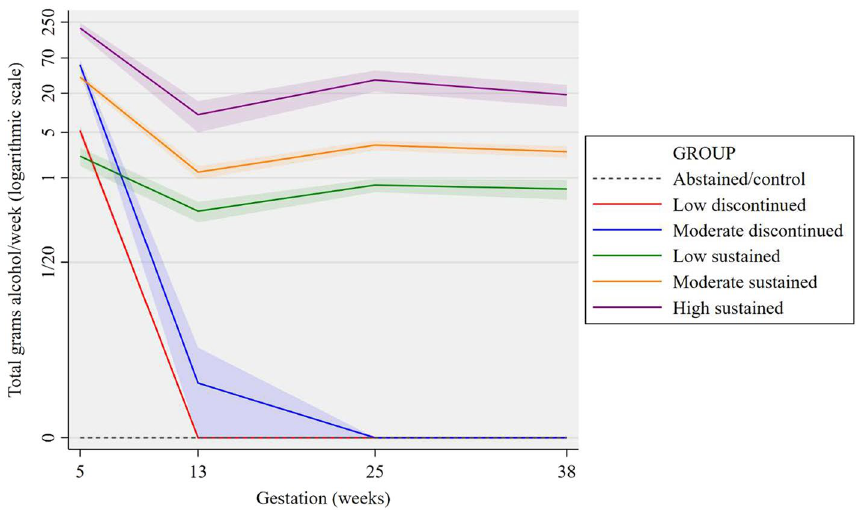
Figure 1. Trajectory groups for prenatal alcohol consumption based on the five-group model with abstainer/ control separation.